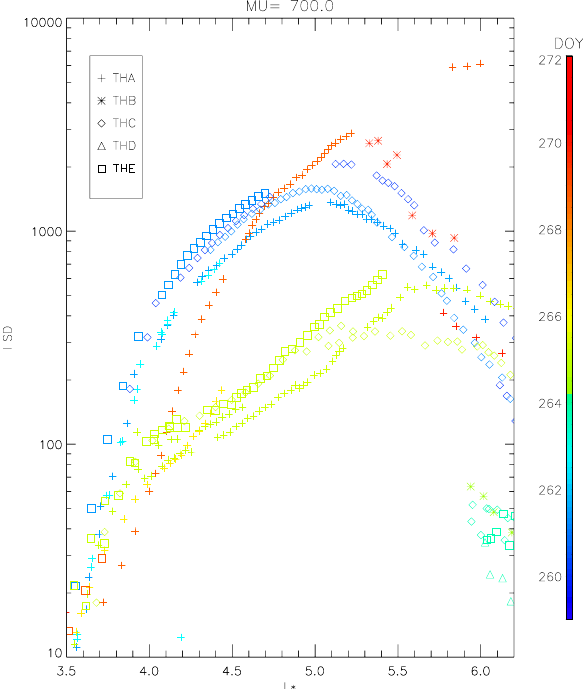
Figure 7. Phase space density vs. L ∗ for fixed M = 700MeVG − 1 , calculated from the observed fluxes, showing the time